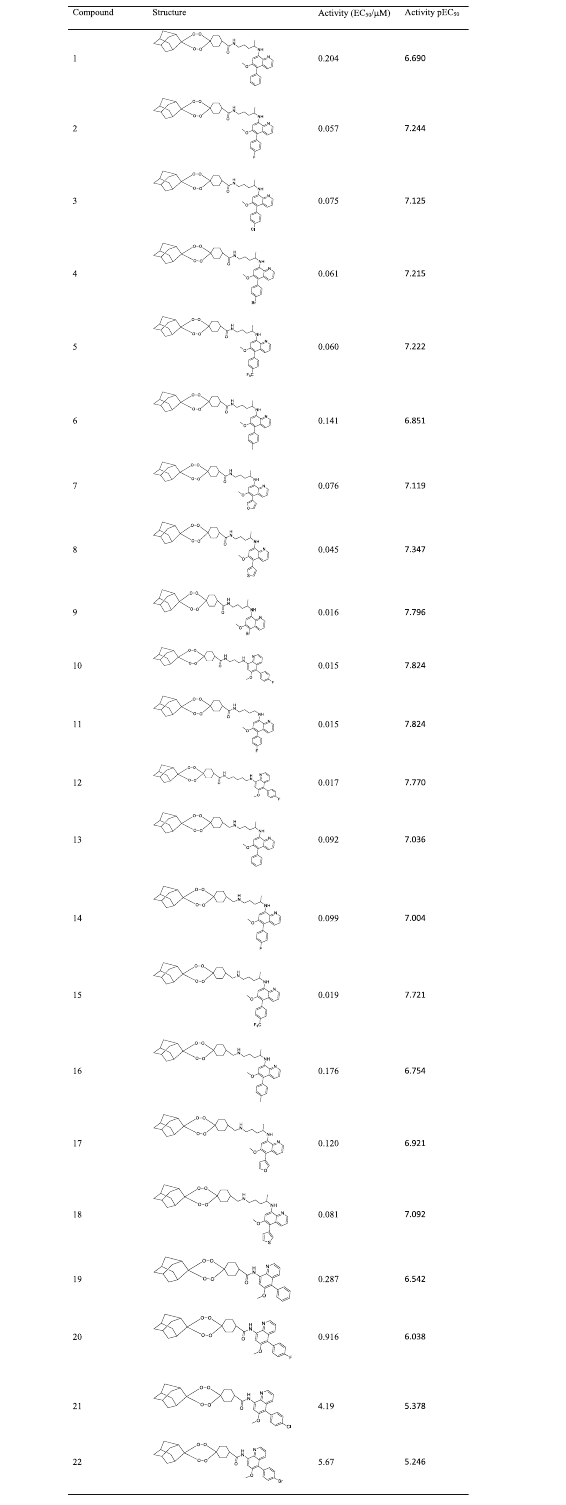
Table 2 The minimum required values for a QSAR model to be Table 1 Molecular structures of 1,2,4,5-tetraoxane-8-